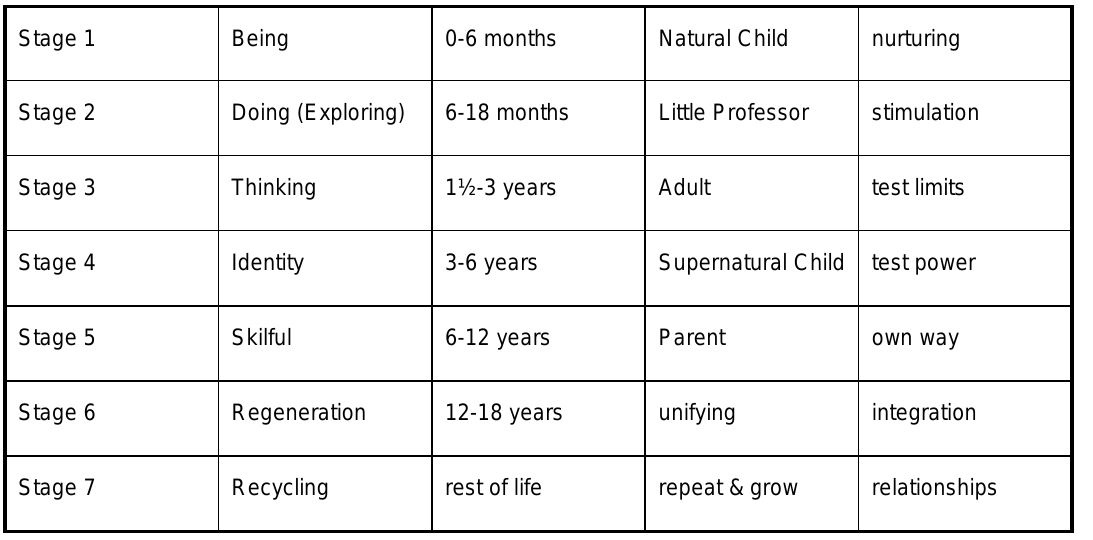
Table 2: Stages of Development (Hay, 2011b,